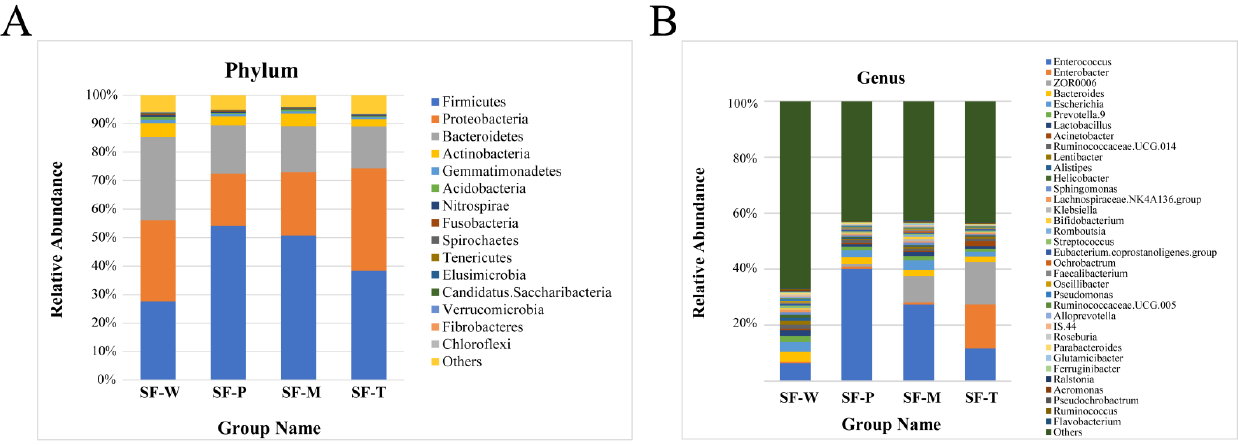
Figure 2. Relative abundance of bacterial taxa in the intestine of larval S. frugiperda fed on four host plants at different classification levels. ( A ): phylum level; ( B ): genus level. plants at different classification levels. ( A ): phylum level; ( B ): genus